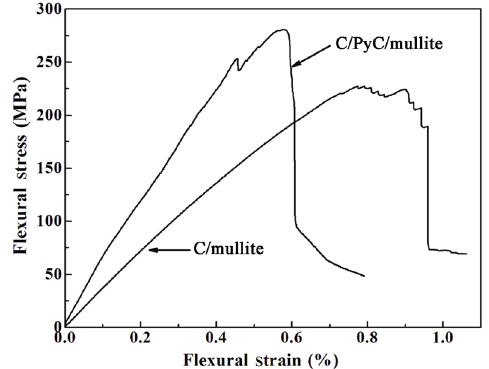
Fig. 3 Stress −strain curves of the C/mullite and the C/PyC/mullite composites.